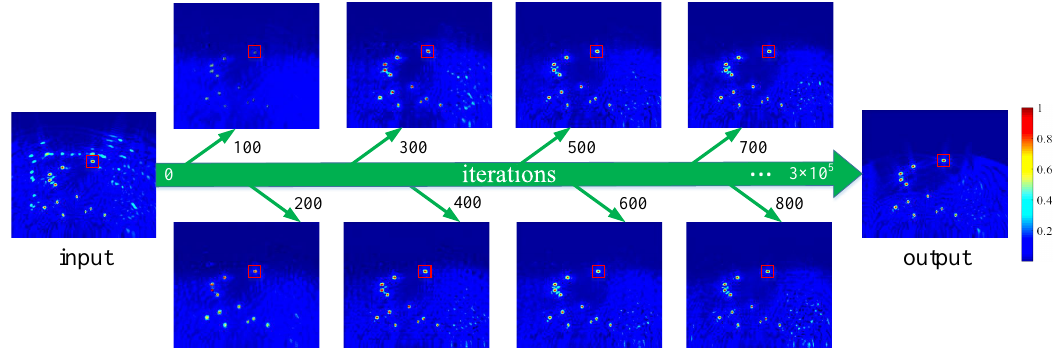
Figure 9. The output of GAN varies from the iterations of Dataset 2. The red rectangles indicate a part of the targets’